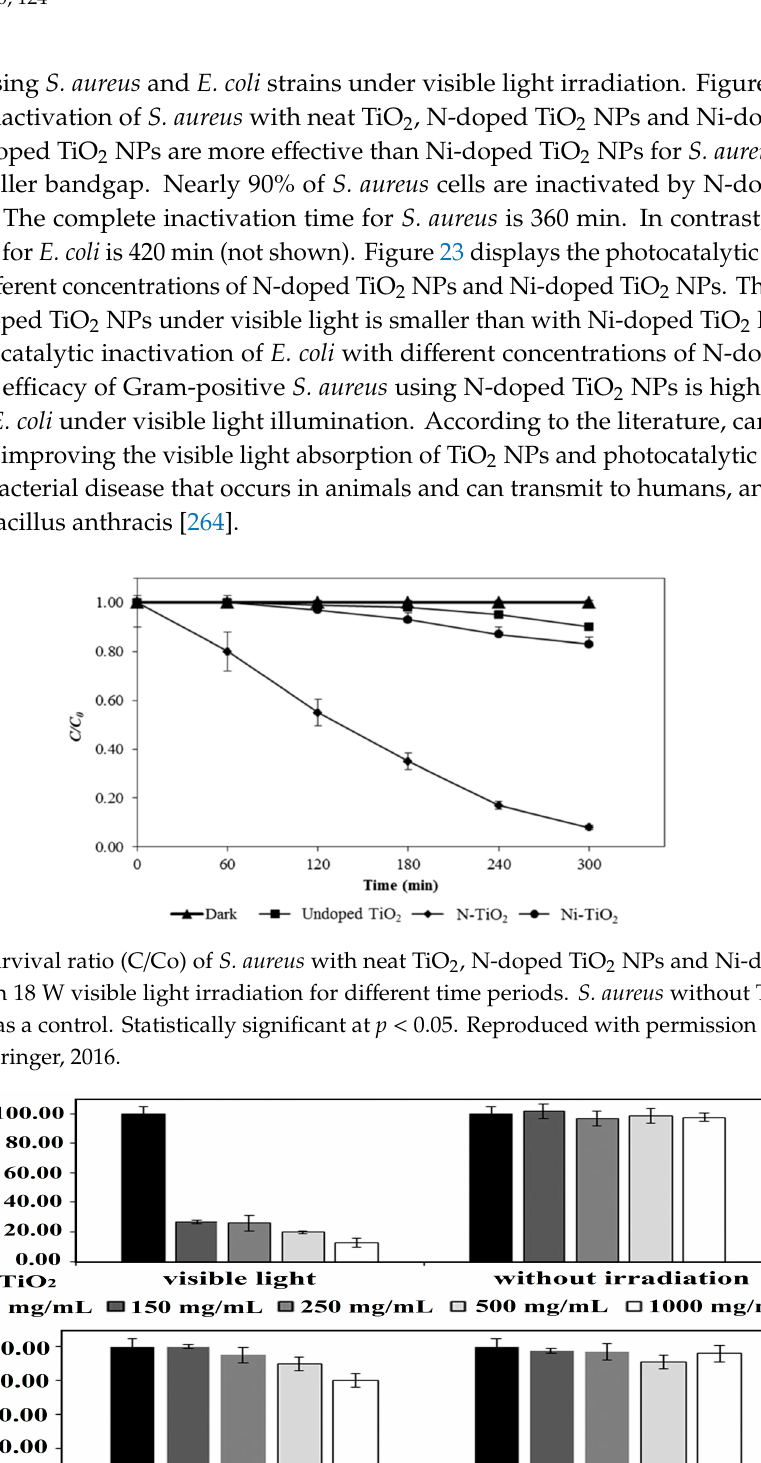
Figure 24. Photocatalytic inactivation of E. coli with N-doped TiO 2 NPs of different concentrations under an 18 W visible light. Statistically significant at p < 0.05. Reproduced with permission from [161]. Copyright Springer, 2016. He et al. fabricated N-doped TiO 2 NPs (30 nm) using the sol-gel technique. The photocatalytic and bactericidal behaviors of N-doped TiO 2 NPs against E. coli under dark and simulated-sunlight conditions were investigated [265]. The bacterial inactivation of this catalyst reaches 90% under simulated sunlight for 2 h, much higher than in the dark. Figure 25 displays photographs of neat TiO 2 and N-doped TiO 2 NPs treated with E. coli in the dark for 24 h, and under visible light for 2 h. Bacteria